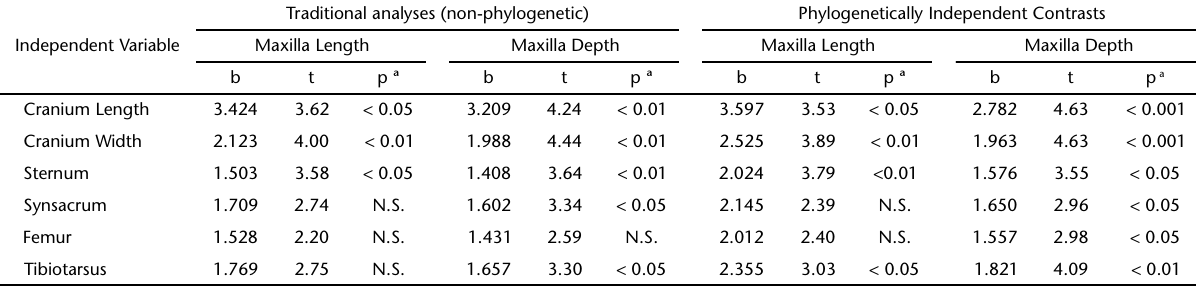
Table IV. Allometric exponents (b) of regression of maxilla length and maxilla depth on other skeletal measures of 21 species of Ramphastidae in traditional analyses and phlogenetically independent contrasts. Independent Variable